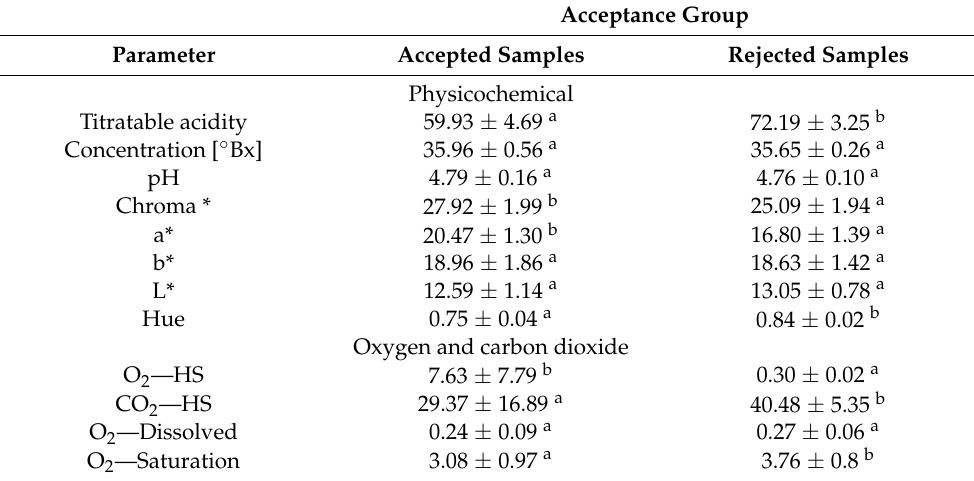
Table 2. Means and standard deviations of the studied physicochemical properties and oxygen features for accepted samples ( n = 6) and rejected samples ( n =